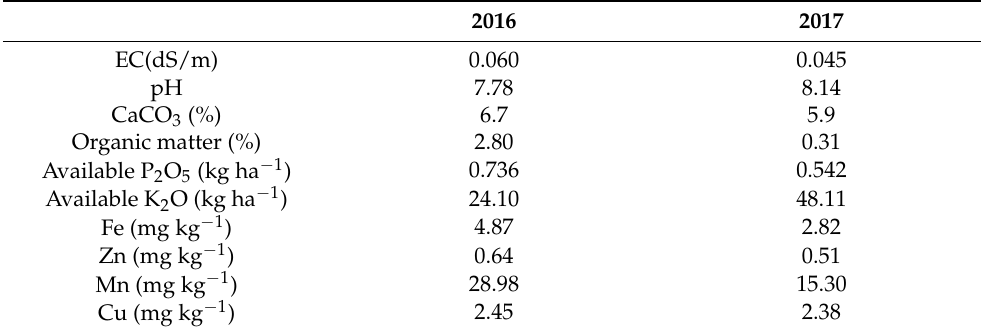
Table 10. Soil characteristics of the research area in 2016 and 2017.